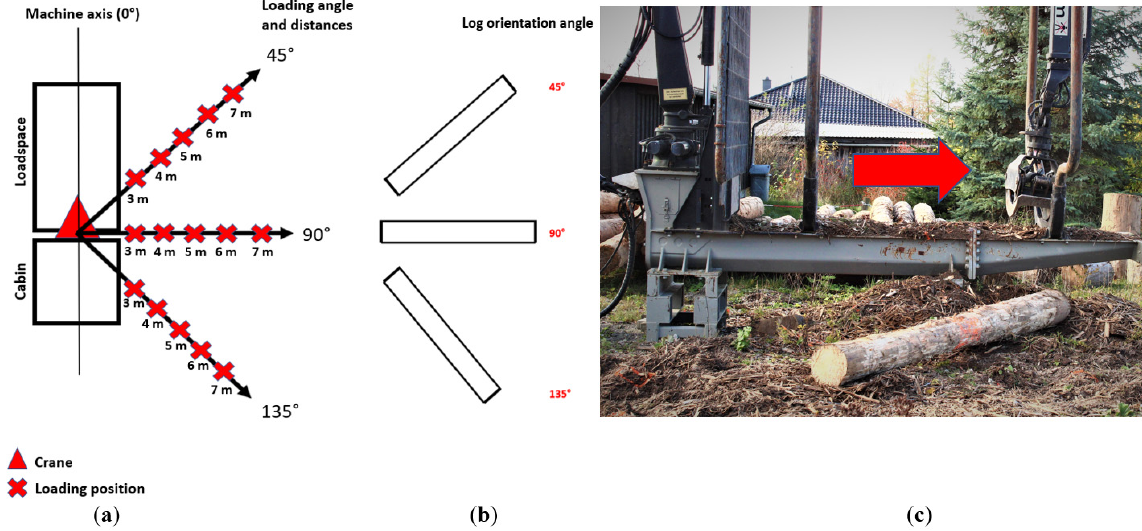
Figure 2. Study setup: ( a ) loading distances and loading angles; ( b ) different log positions; and ( c ) start position of boom before loading cycles.